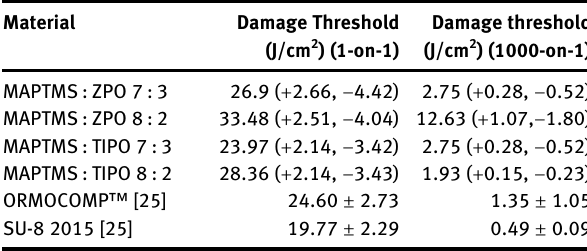
Table  : ns LIDT characterization. Material